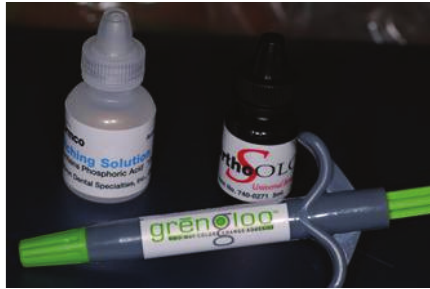
Figure 2: Phosphoric acid, bonding and composite resin.